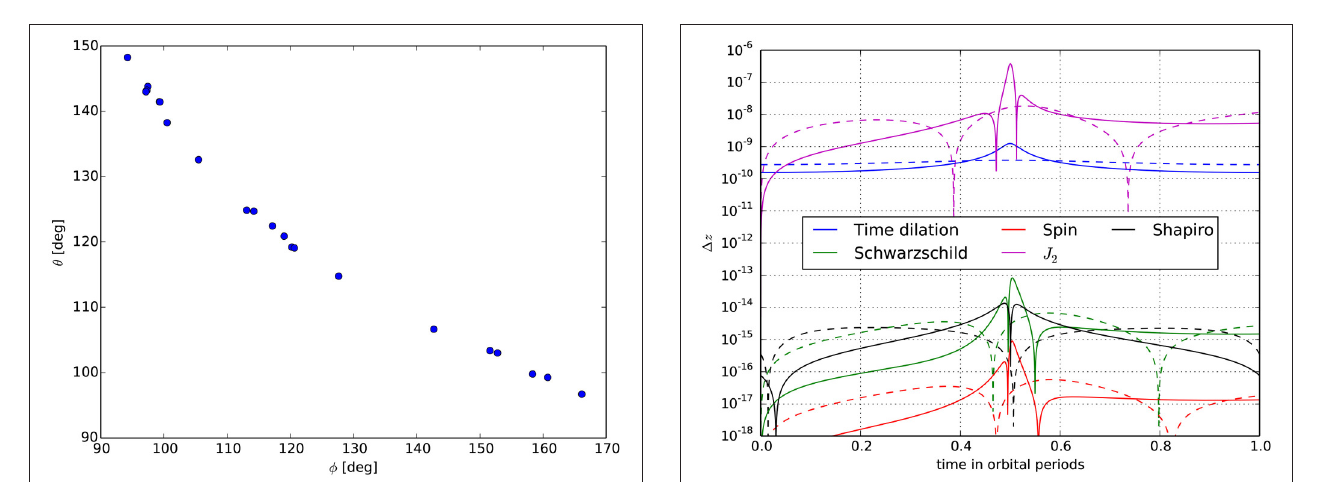
FIGURE 6 | Redshift curves of terrestrial satellites. The dashed curves give the r peri b for Juno science orbits. Here ˆ b is FIGURE 4 | Orientation of the vector ˆ × ˆ results for an orbit with the semi-major axis and eccentricity corresponding to the line of sight to Juno , and θ , φ in the Figure are with respect to to Jupiter’s the ones of the Galileo 5 and 6 satellites. The solid lines give the results for a axis. The timing signal is sensitive to the planetary spin projected along these typical satellite with high eccentricity while all the other Keplerian elements and various directions. the observer’s position were left the